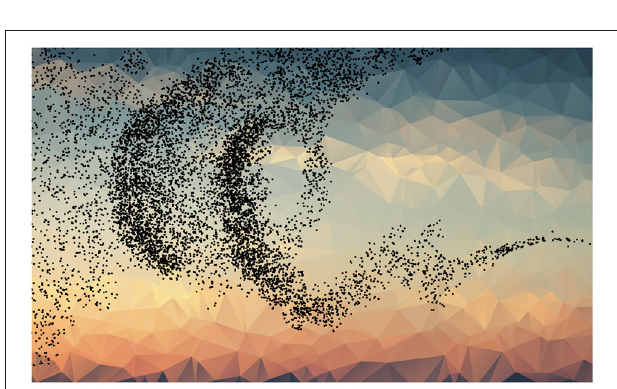
FIGURE 6 | A large amount of local and global geometric information is contained in a flock of birds.